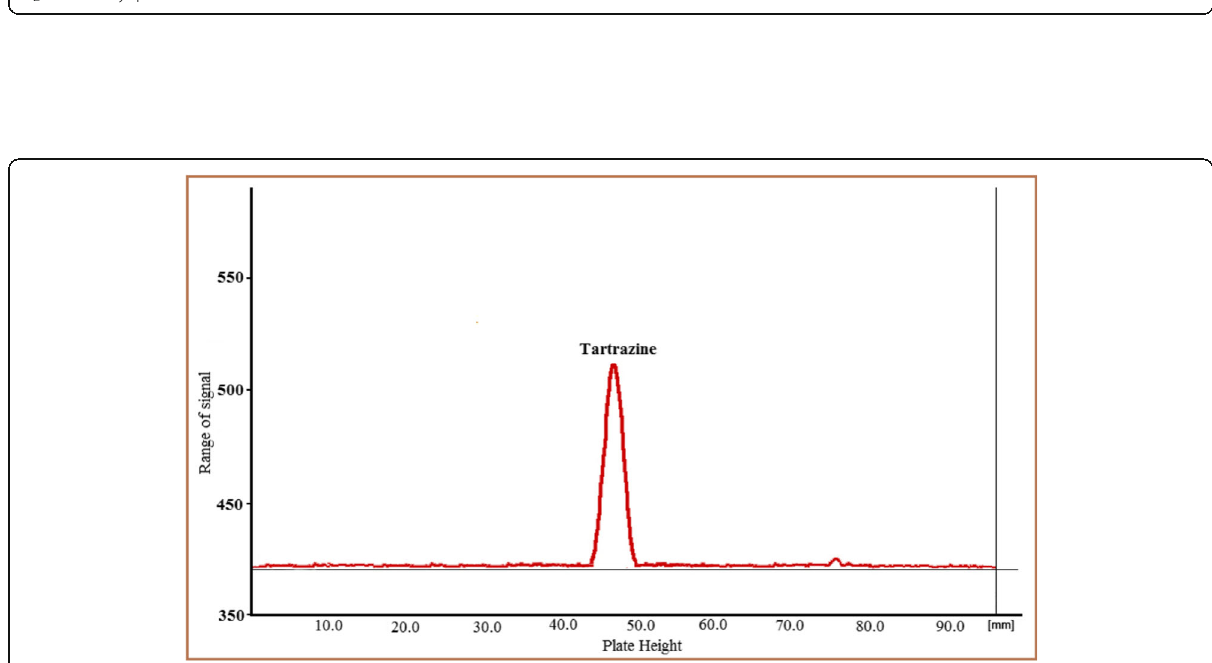
Fig. 9 Densitographic presentation of representative separations of three-component mixtures of dyes achieved with M 3 mobile phase on S